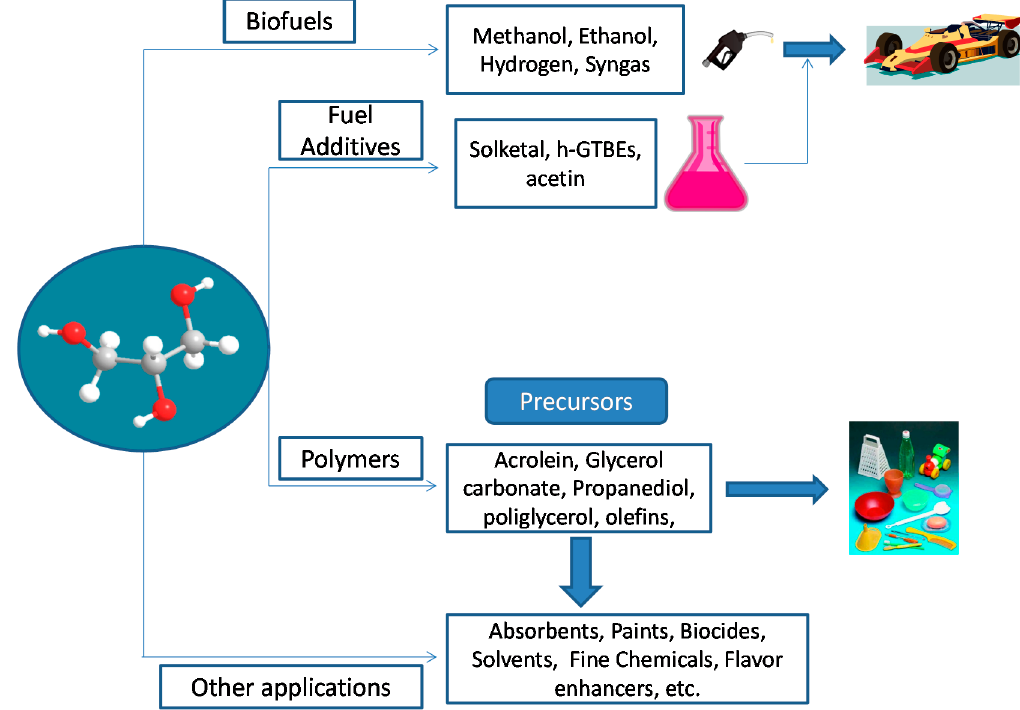
Figure 3. Main application fields of glycerol derivatives.